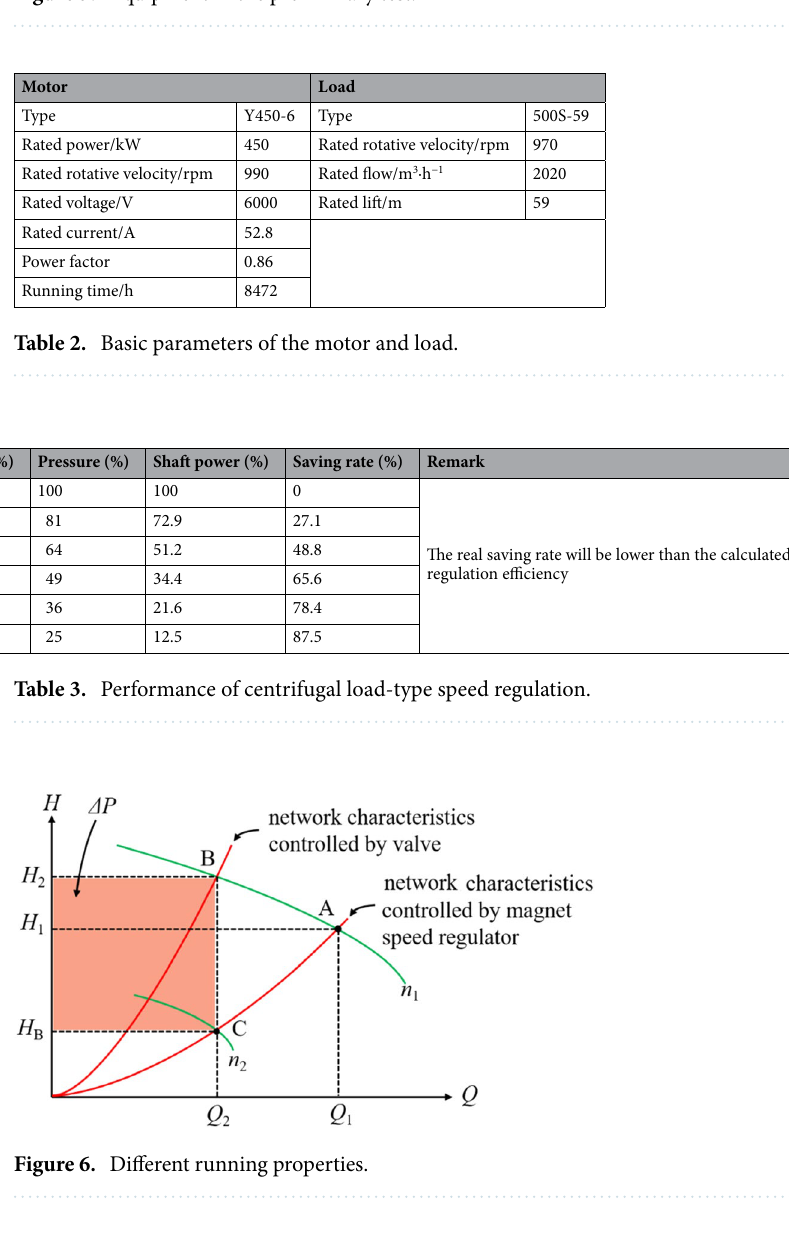
Figure 5. Equipment in the preliminary test.